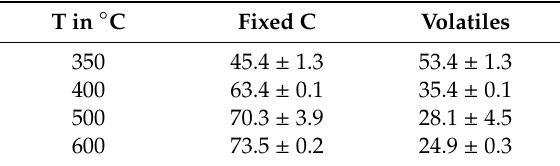
Table 2. Proximate analysis of the HNS-biochar (BC) samples in wt% (dry-based). Ash data are given in Table